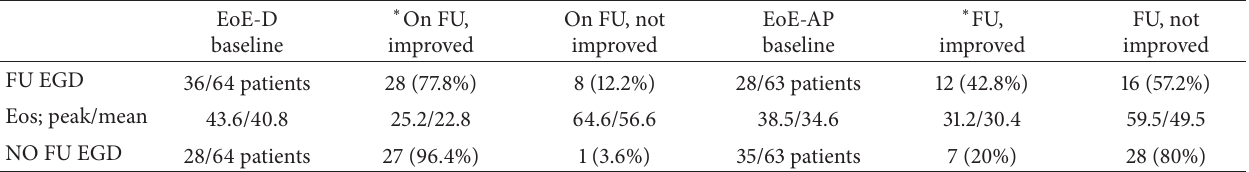
Table 5: Follow-up EGD: correlation of symptom and eosinophil count changes. EoE-D